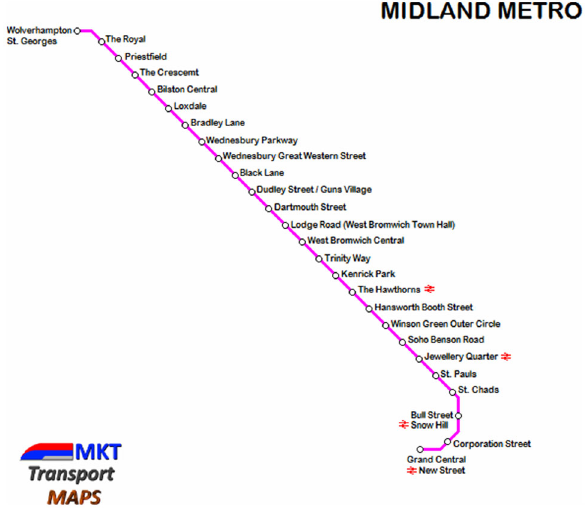
Fig. 2 The West Midlands Metro